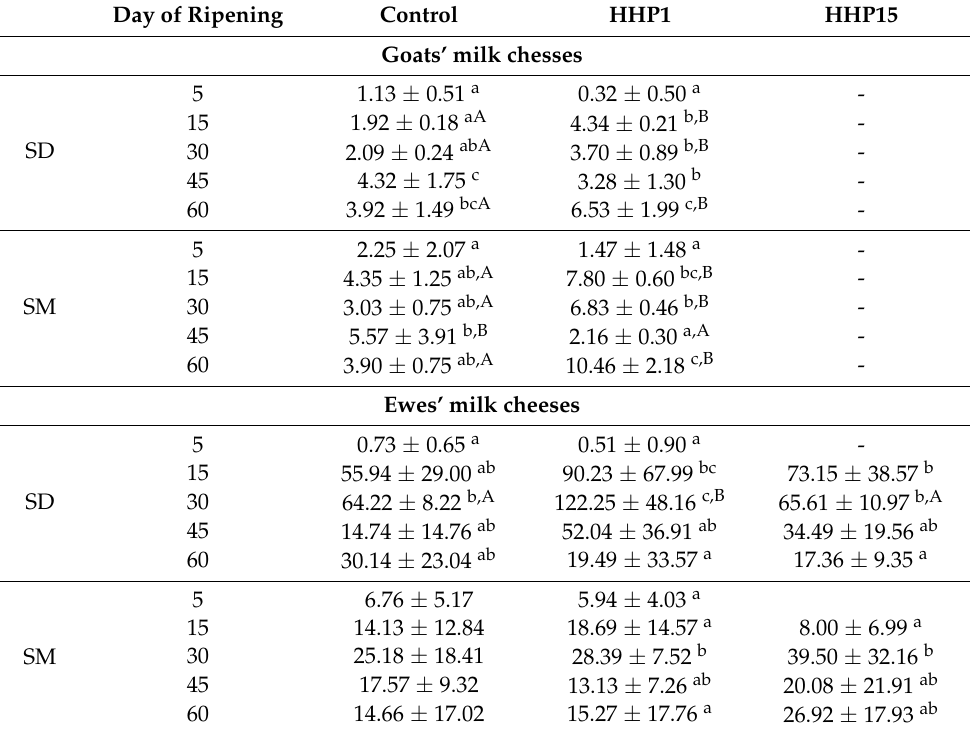
Table 7. Polyamine content (mean values ± standard deviation expressed as mg/kg in dry basis) during the ripening of goats’ and ewes’ raw milk cheese samples with and without HHP treatment. (SD: spermidine, SM: